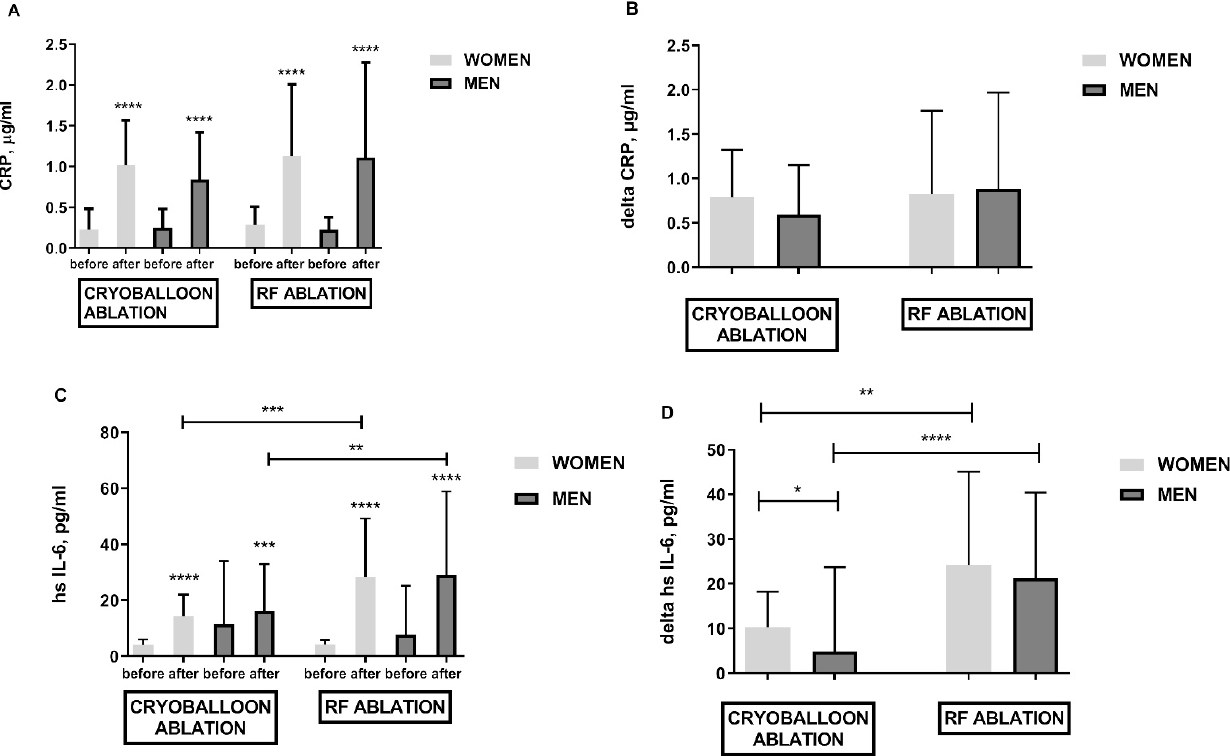
Figure 2. Biomarkers of inflammation in obese females and obese males following cryoballoon and RF ablation; panel ( A )—CRP elevation in response to cryo and RF ablation; panel ( B )—CRP difference before and after cryoballoon and RF ablation (delta); panel ( C )—hs Il-6 elevation in response to cryoballoon and RF ablation; panel ( D )—hs Il-6 difference before and after cryoballoon and RF ablation (delta). Asterisks represent a significant difference: * p < 0.05, ** p < 0.01, *** p < 0.001, **** p < 0.0001.